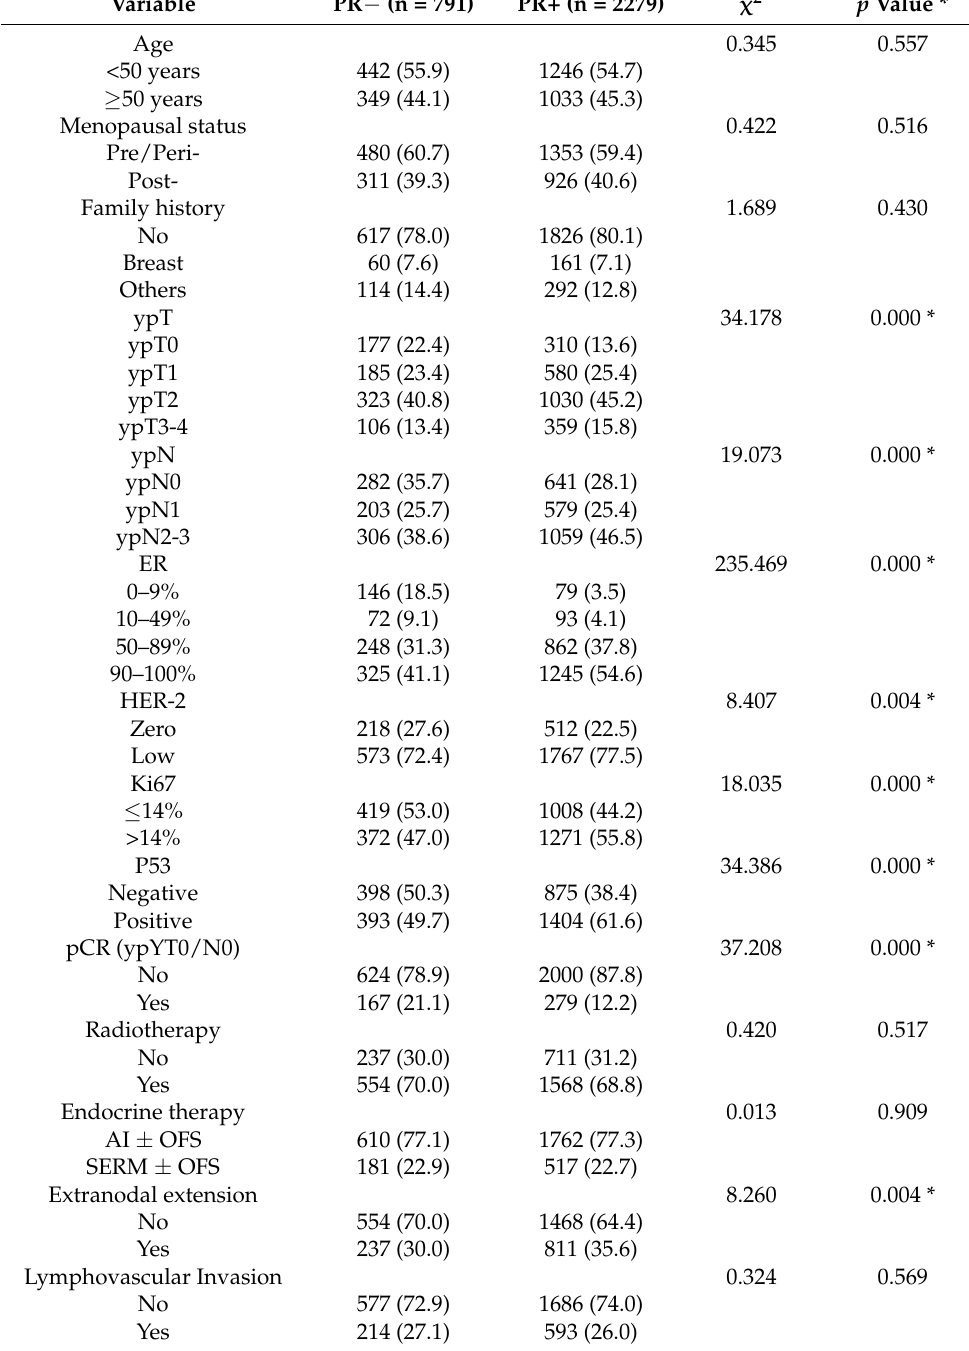
Table 4. Baseline patient characteristics stratified by PR status (PR negativity vs. PR